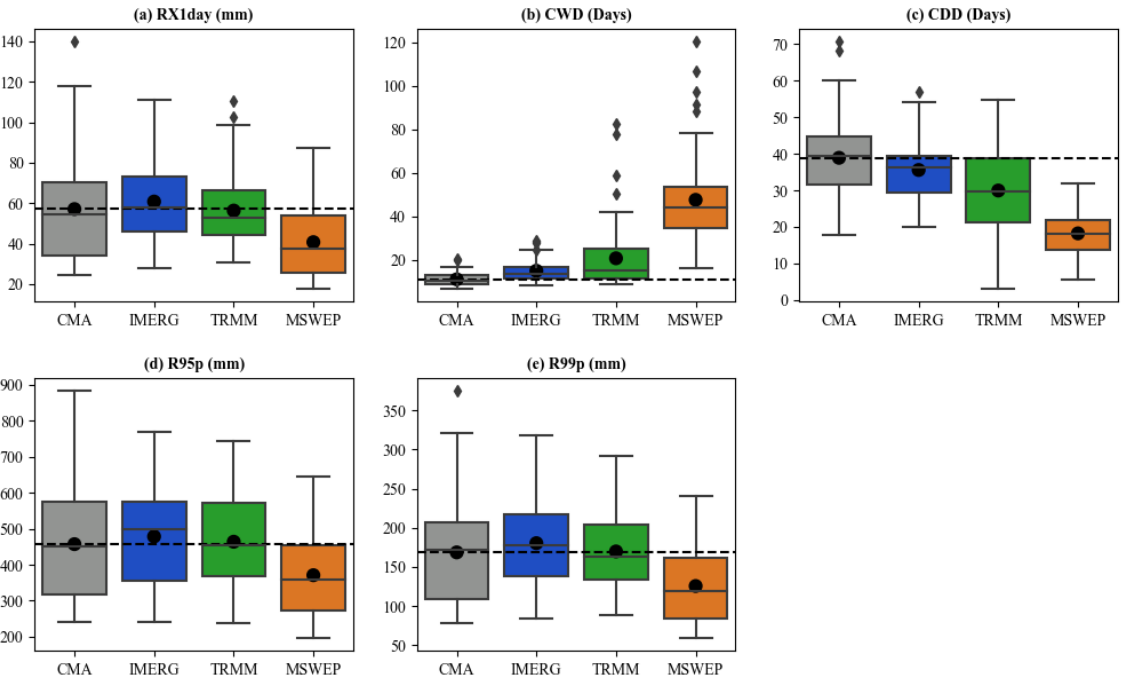
Figure 5. Boxplots for the three maximum indices: ( a ) RX1day, ( b ) CWD, and ( c ) CDD, and two percentile indices, ( d ) R95p and ( e ) R99p, for the observed data and the three products.